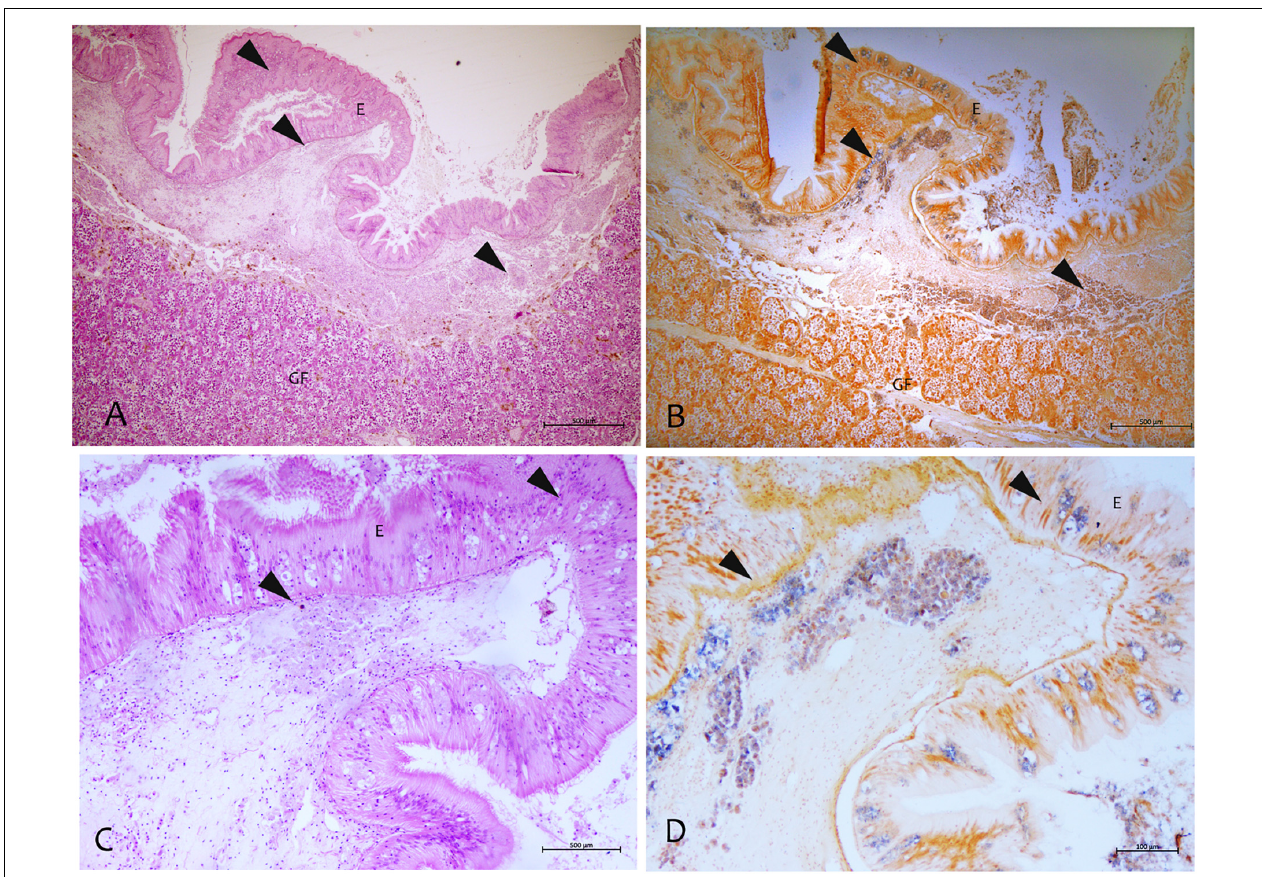
FIGURE 6 | Mycobacterium identified by the in situ hybridization technique in samples of P. nobilis in H&E (A–C) compared with the in situ (B–D) . (A,B) General view of the gonad with signal in the connective tissue and epithelia (arrowheads) (B) and detail showing the labeled mycobacterium cells (arrowheads). (C,D) Detection of mycobacteria in the immune cells aggregates of mantle underline connective and epithelia using the digoxigenin-labeled probe. GF, Gonadal Follicle; E,